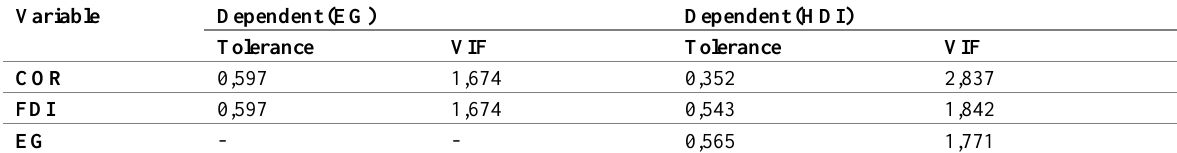
Table 5: The Result of Multicollinearity Test